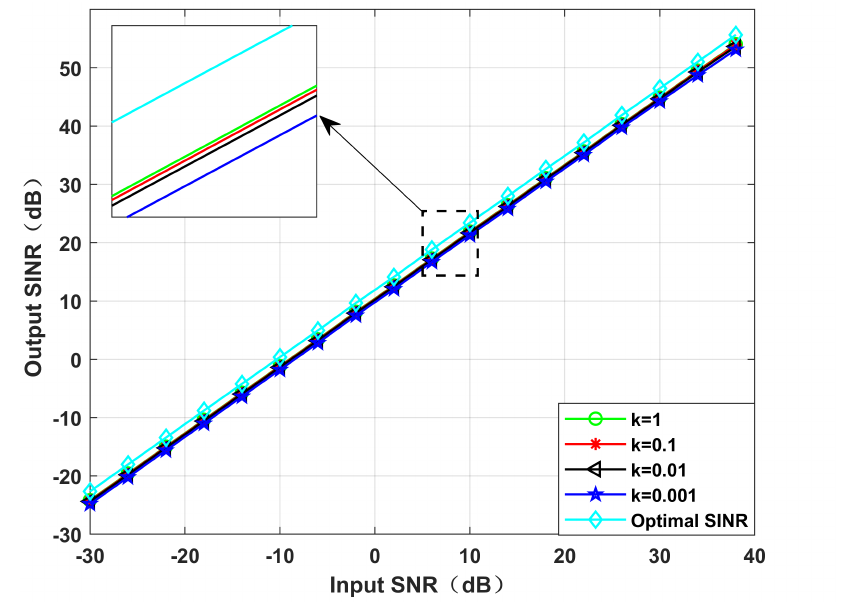
Figure 4. Output SINR versus the input SNR for different values of k . Simulation 1. Simulation 2. Different ϕ